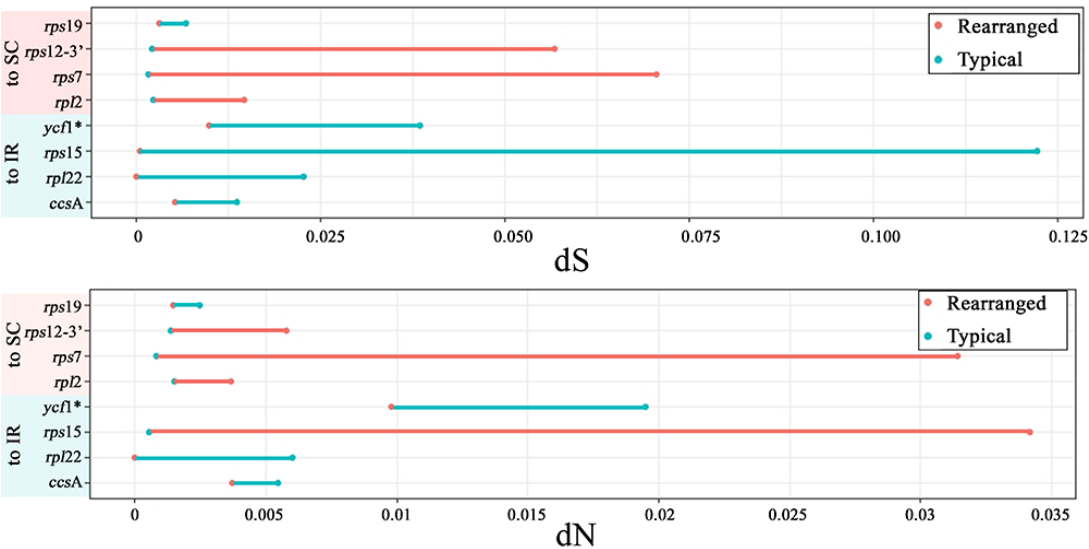
Figure 4. Comparison of synonymous (dS) and nonsynonymous (dN) substitution rates between species with rearranged and conserved plastomes in eight regions. A region with a significant p -value ( p -value < 0.05) was tagged by an asterisk (*) in its gene name. The red color in the bar graph indicates an acceleration of the substitution rates; the blue color indicates a deceleration of the substitution rates.